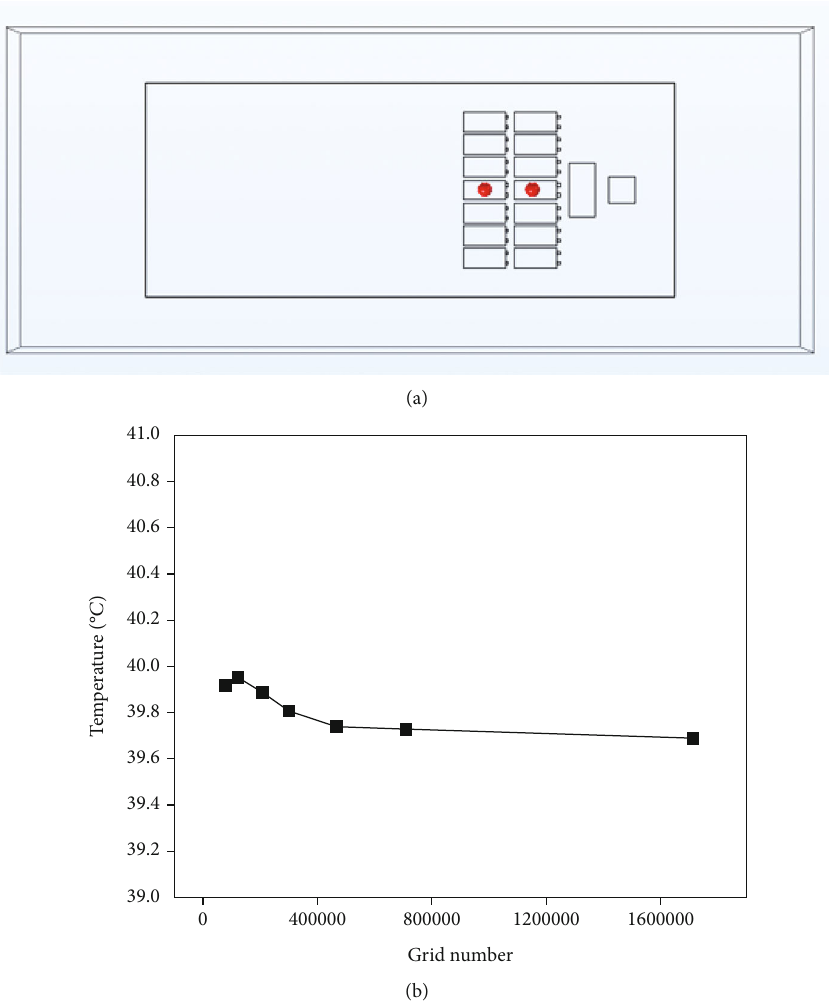
Figure 7: Details and results of grid independence tests: (a) detection point diagram and network and (b) independence veri fi cation